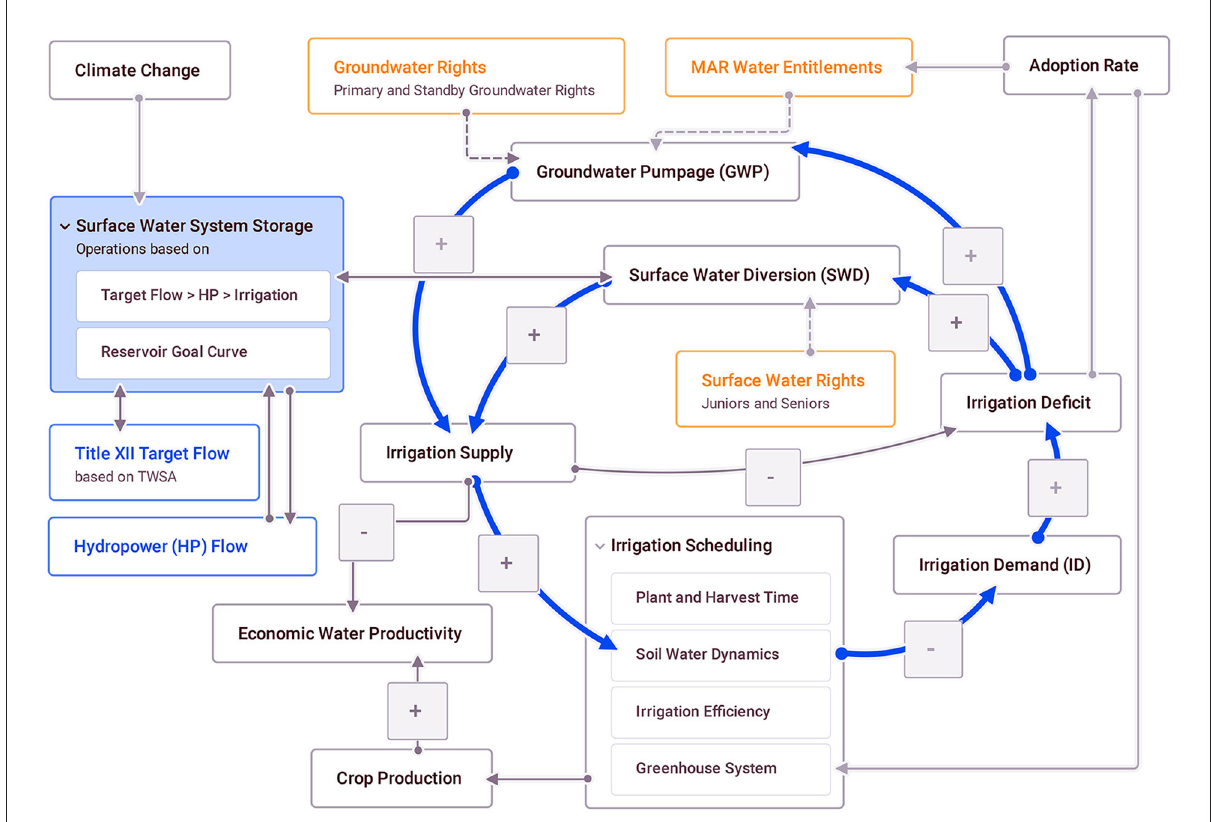
FIGURE3 Conceptual map of the water storage management tool. The plus sign “ + ” indicates a positive relationship between two connected variables, where they change in the same direction, and the negative sign “–” means that two variables change in the opposite